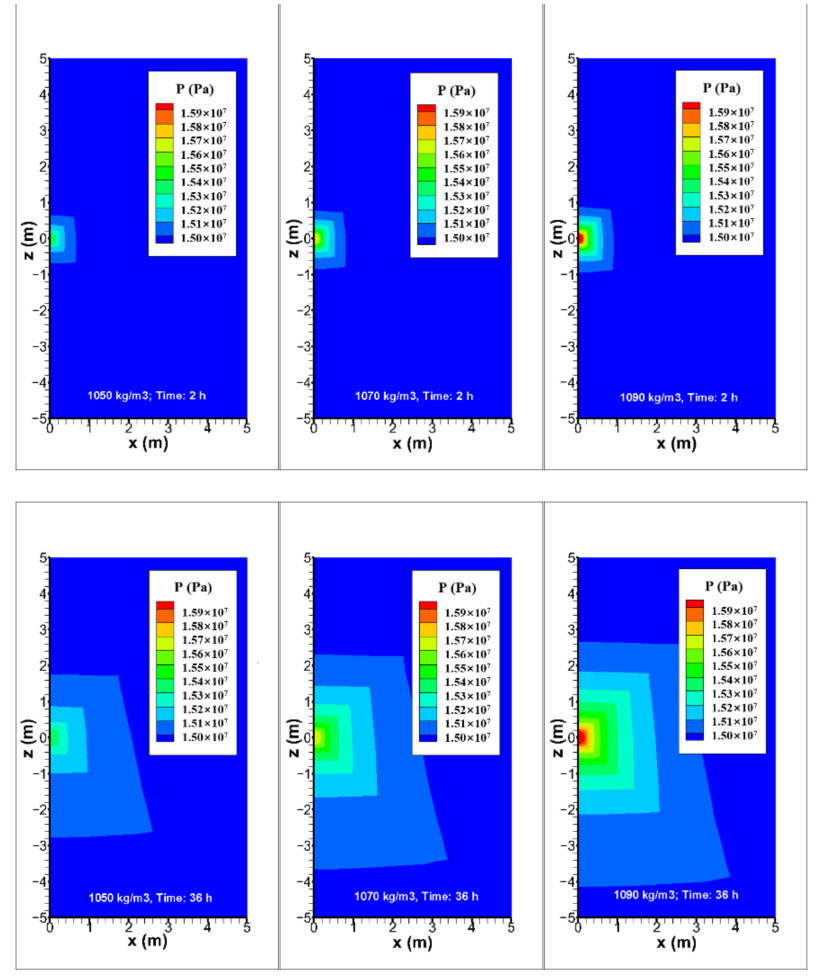
Figure 8. The pore pressure distribution evolution of the near-wellbore reservoir with the different drilling fluid